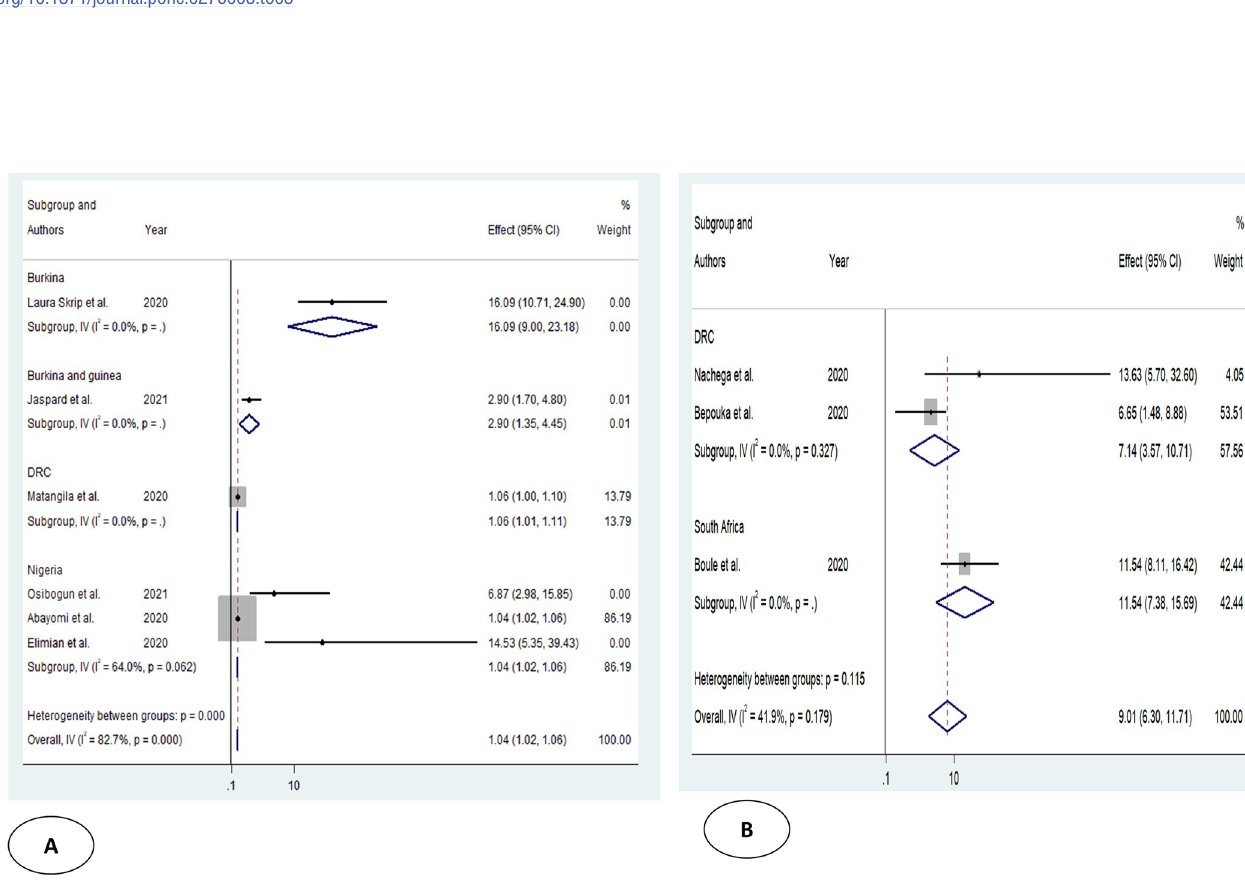
Fig 2. Forest plot showing the estimate for advanced age on COVID-19 mortality. Forest plots of studies using A. Odds ratio, B. Hazard